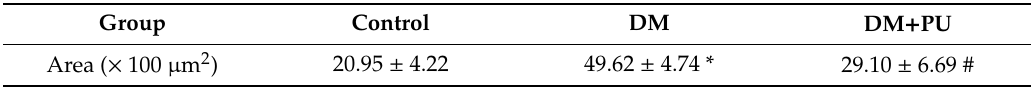
Table 1. Glomerular tuft area of mice ( x ± s, n = 8).